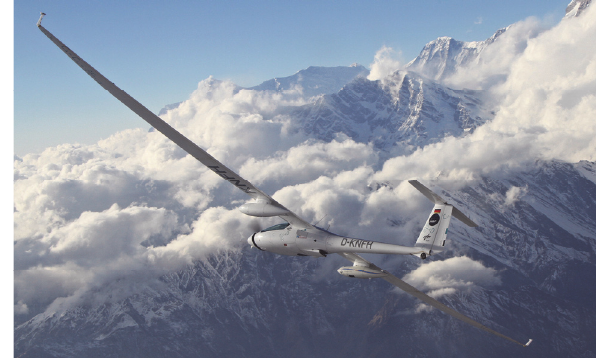
Figure 4. Stemme S10-VTX motorglider during a test flight in a high mountain area. The aerial camera is placed in the right underwing pod.